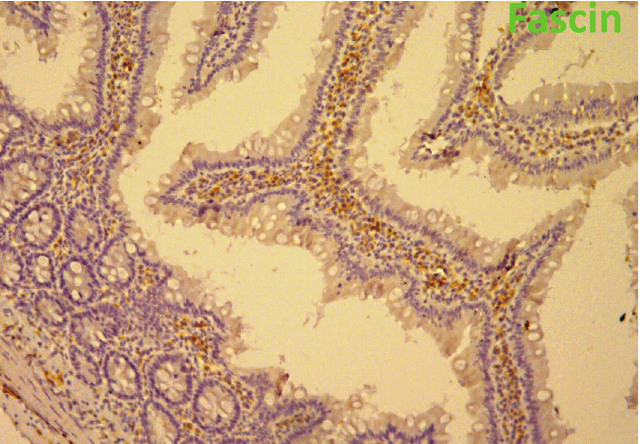
Figure 1 - Representative microphotograph of fascin staining in the small intestine of a rat from the control group. Fascin expression is not found in the epithelial cells, while moderate staining in observed in the lamina propria.